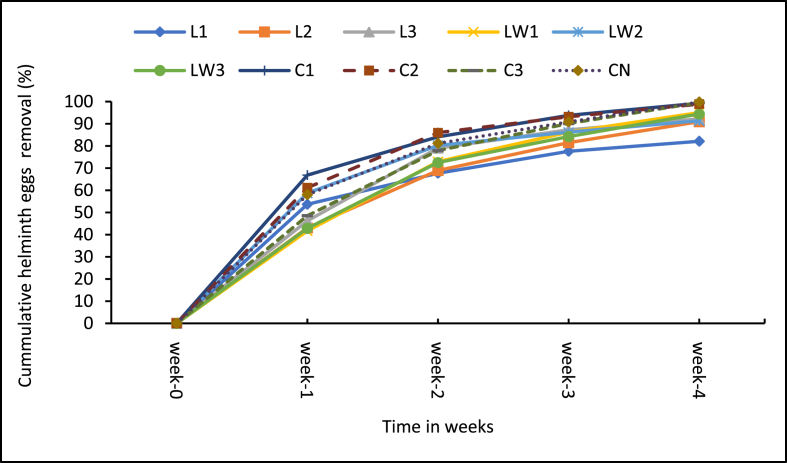
Total helminth egg removal percentage. Note: L1 = 25 mL stock LSEC, L2 = 50 mL stock LSEC, L3 = 75 mL stock LSEC, LW1 = 0.1% DF, LW2 = 0.5% DF, LW3 = 1% DF, C1 = 5 g Calcium carbide, C2 = 8 g calcium carbide, C3 = 10 g calcium carbide, CN = control.